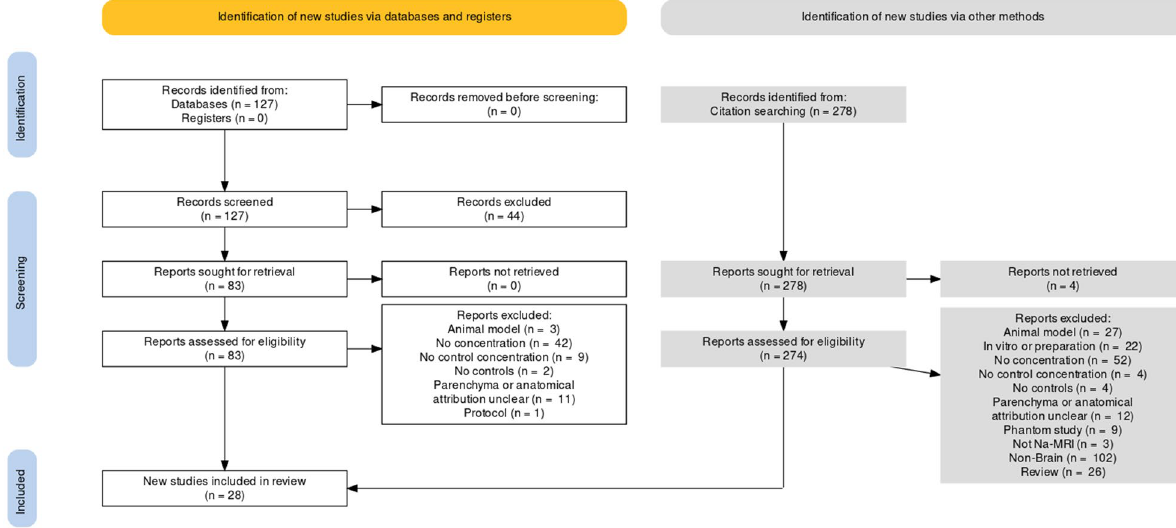
Figure 2. PRISMA flow diagram for search performed 12/7/2021. Generated with the PRISMA 2020 app 83